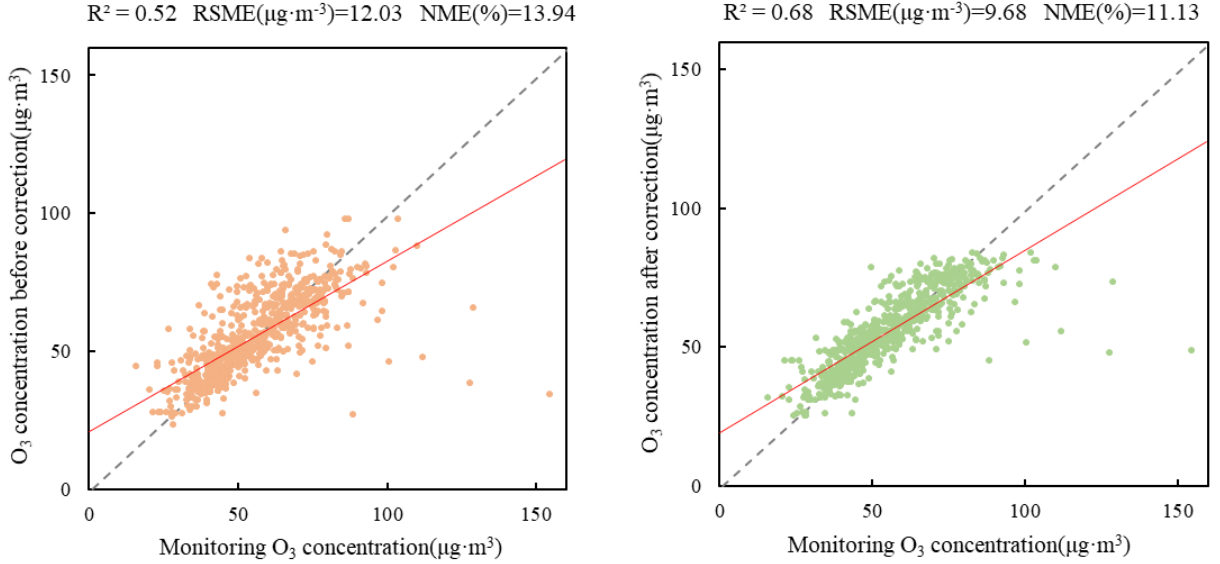
Figure A1. Correlation and statistical indexes between monthly O 3 concentration and monthly monitored O 3 concentration before and after correction. Table A1. Meteorology, emission, and landscape pattern ecological detection results.